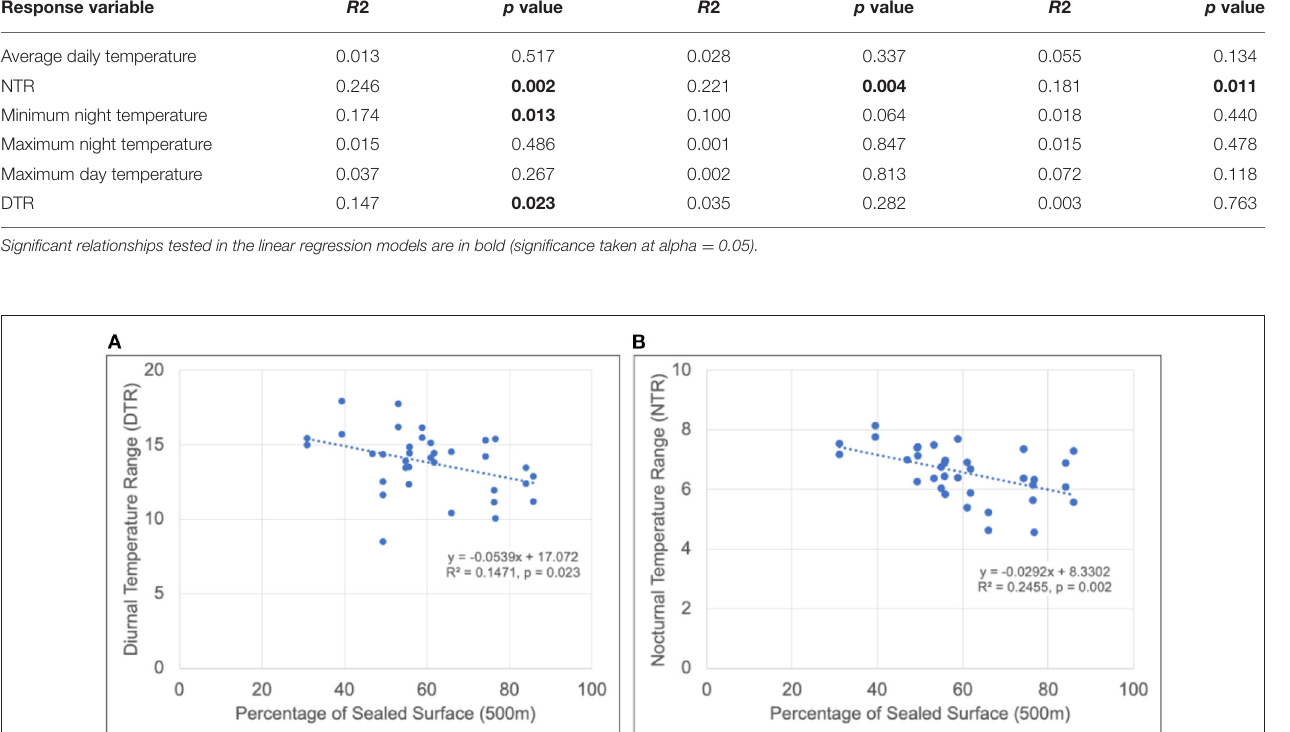
TABLE 3 | Relationships between the temperature parameters (response variables) and impervious cover at the landscape scales measured (500-m, 1,000-m, 2,000-m radius surrounding each site).